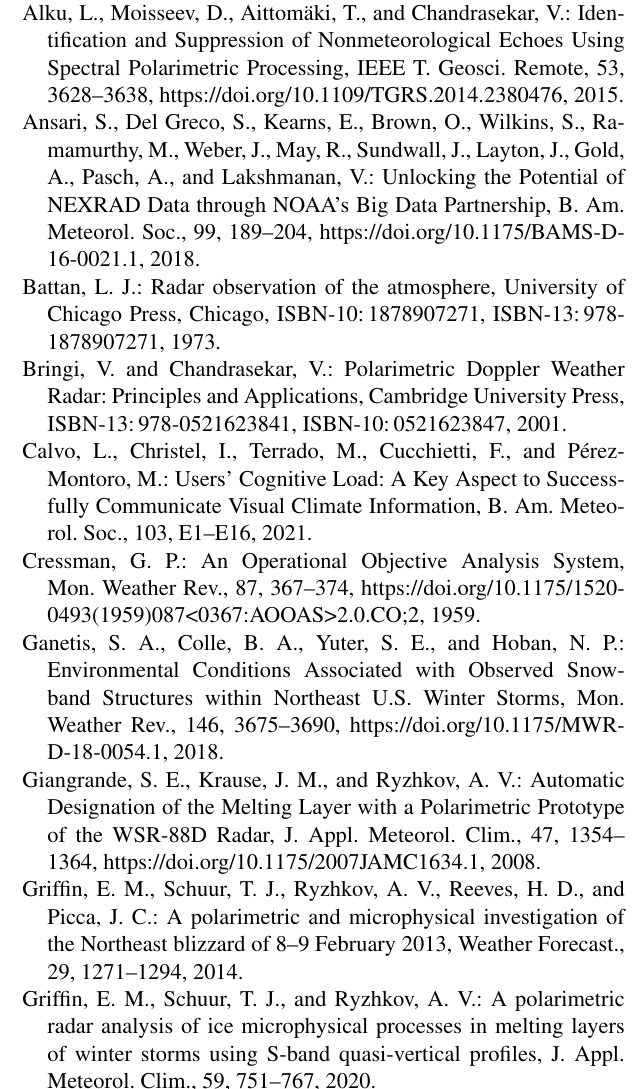
transition between snow and melting precipitation in the radar re- gional map. (a) Image-muted reflectivity valid at 16:11:03UTC with the ER-2 flight leg (green line), aircraft location correspond- ing to time shown in the bottom panel is at the arrowhead along the leg. Locations of ASOS observations in Fig. 4 are annotated with stars and black labels. (b) Vertical cross-section of reflectivity from NASA EXRAD radar with current aircraft location near the top of the vertical green line. Time on the right corresponds to aircraft po- sition. The black X indicates the height of the point in panel a that varies along the 0.5 ◦ elevation angle scans used to construct the re- gional maps (goes with Fig. 2). Animation-Figure-5 (https://doi.org/10.5446/57313, Filename: fig05_animation.mp4): animated plot of image-muted regional map with reconstructed RHIs and reanalysis temperature vertical cross- section from the KOKX radar on 8 February 2013. (a) Correlation coefficient and (b) image-muted reflectivity (dBZ) 0.5 ◦ elevation angle PPI plots for the KOKX radar valid 21:00:00UTC 8 February to 00:00:00UTC 9 February 2013. Green line in panels (a) and (b) indicates location of reconstructed RHI cross-sections from (c) the correlation coefficient and (d) image-muted reflectivity. (e) ERA5 reanalysis temperature cross-section interpolated to the plane of the RHI. Black line in panel (e) indicates 0 ◦ C isotherm. (goes with Fig. 5). Animation-Figure-6 (https://doi.org/10.5446/57314, Filename: fig06_animation.mp4): animated plot of image-muted regional map with reconstructed RHIs and reanalysis temperature vertical cross- section from the KDIX radar on 1 December 2019. (a) Correlation coefficient and (b) image-muted reflectivity (dBZ) 0.5 ◦ elevation angle PPI plots for the KDIX radar valid 15:00:00 to 20:00:00UTC on 1 December 2019. Green line in panels (a) and (b) indicates location of reconstructed RHI cross-sections from (c) the correla- tion coefficient and (d) image-muted reflectivity. (e) ERA5 reanal- ysis temperature cross-section interpolated to the plane of the RHI. Black line in panel (e) indicates 0 ◦ C isotherm (goes with Fig.